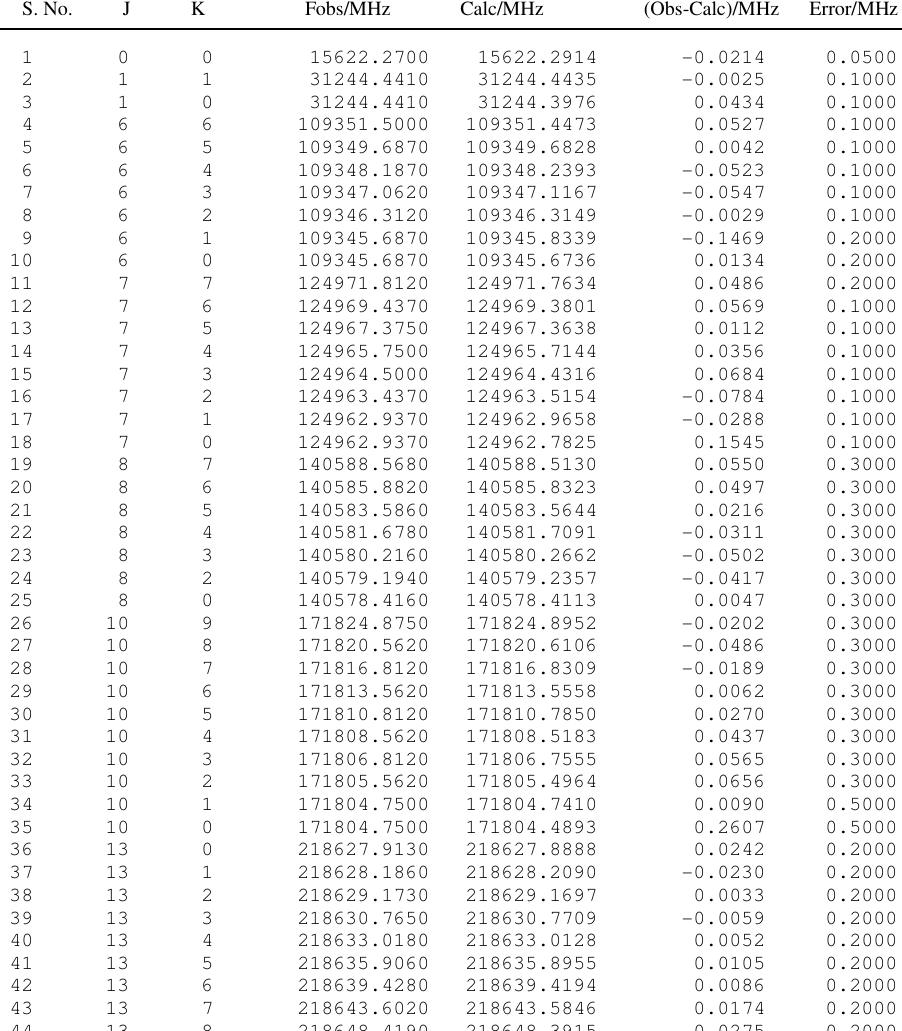
in v = 1 State 3 2